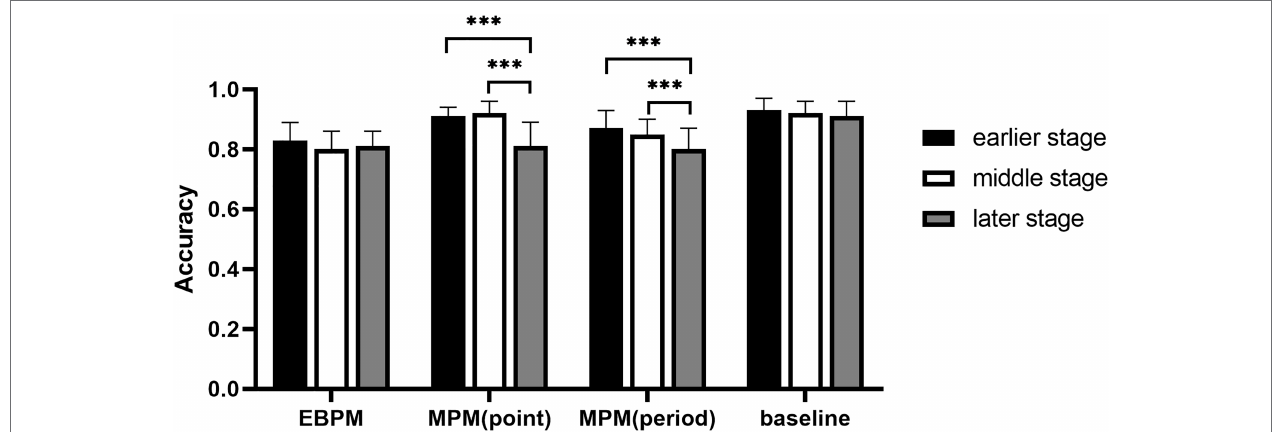
FIGURE 1 | The accuracy of ongoing tasks in different groups at different stages under high cognitive load. *** p < 0.01.